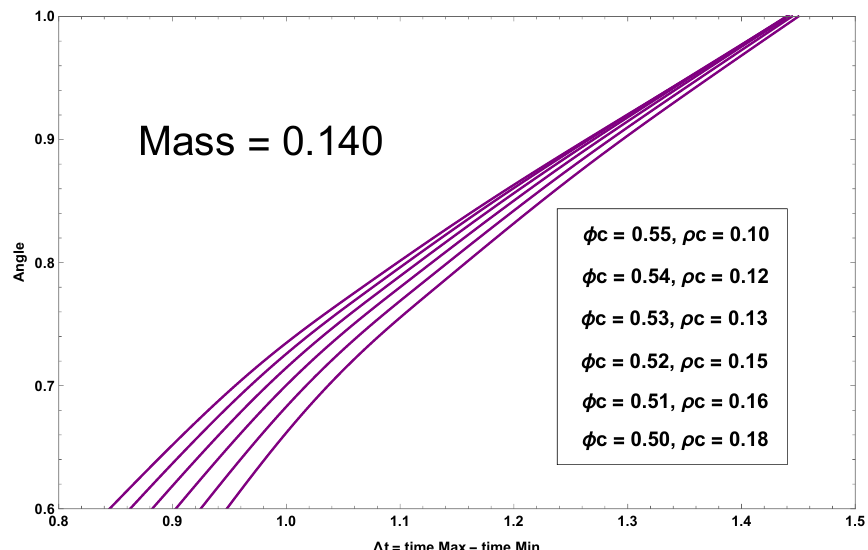
Figure 4. Close-up to the plot of the angle (cid:12) vs (cid:1) t for solutions with di(cid:11)erent values of (cid:26) c and (cid:30) c , and total mass M Total = 0 : 140.